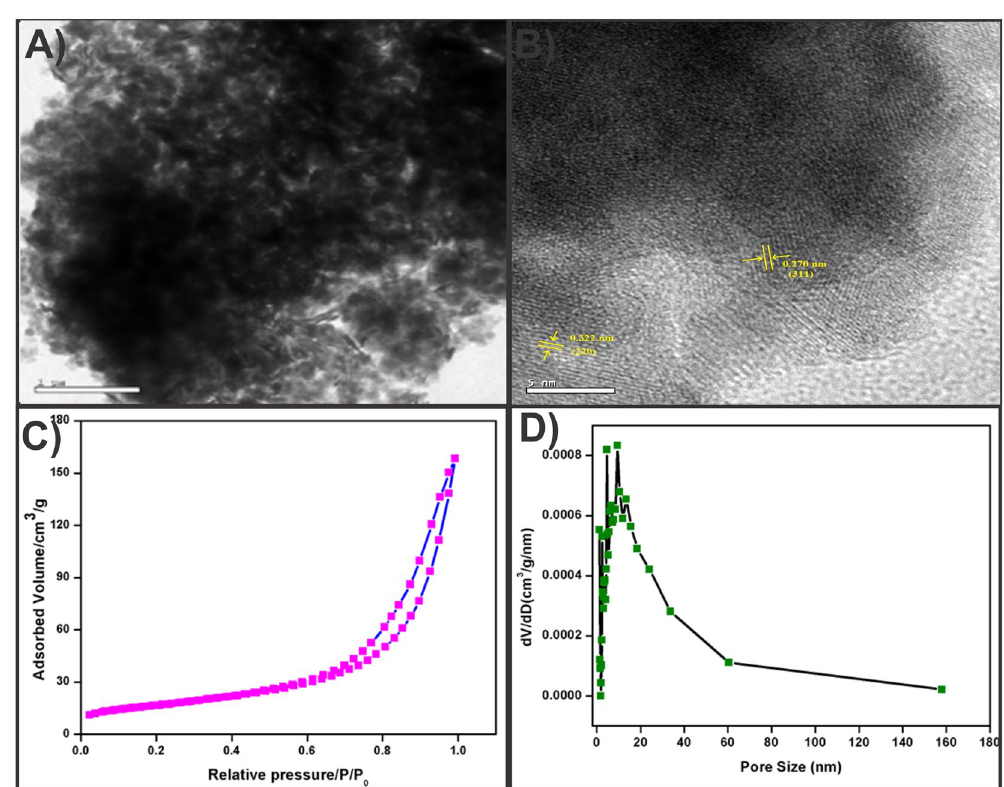
Figure 4. TEM image ( A ) and HR-TEM ( B ) of porous MnCo 2 O 4 spinel compound ( C ) N 2 adsorption– desorption isotherms and ( D ) the pore size distribution of the MnCo 2 O 4 spinel